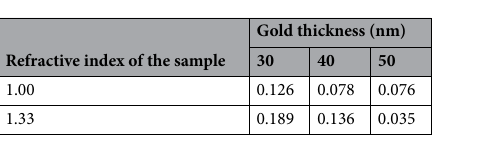
Table 2. Root mean square phase error in rad of the test